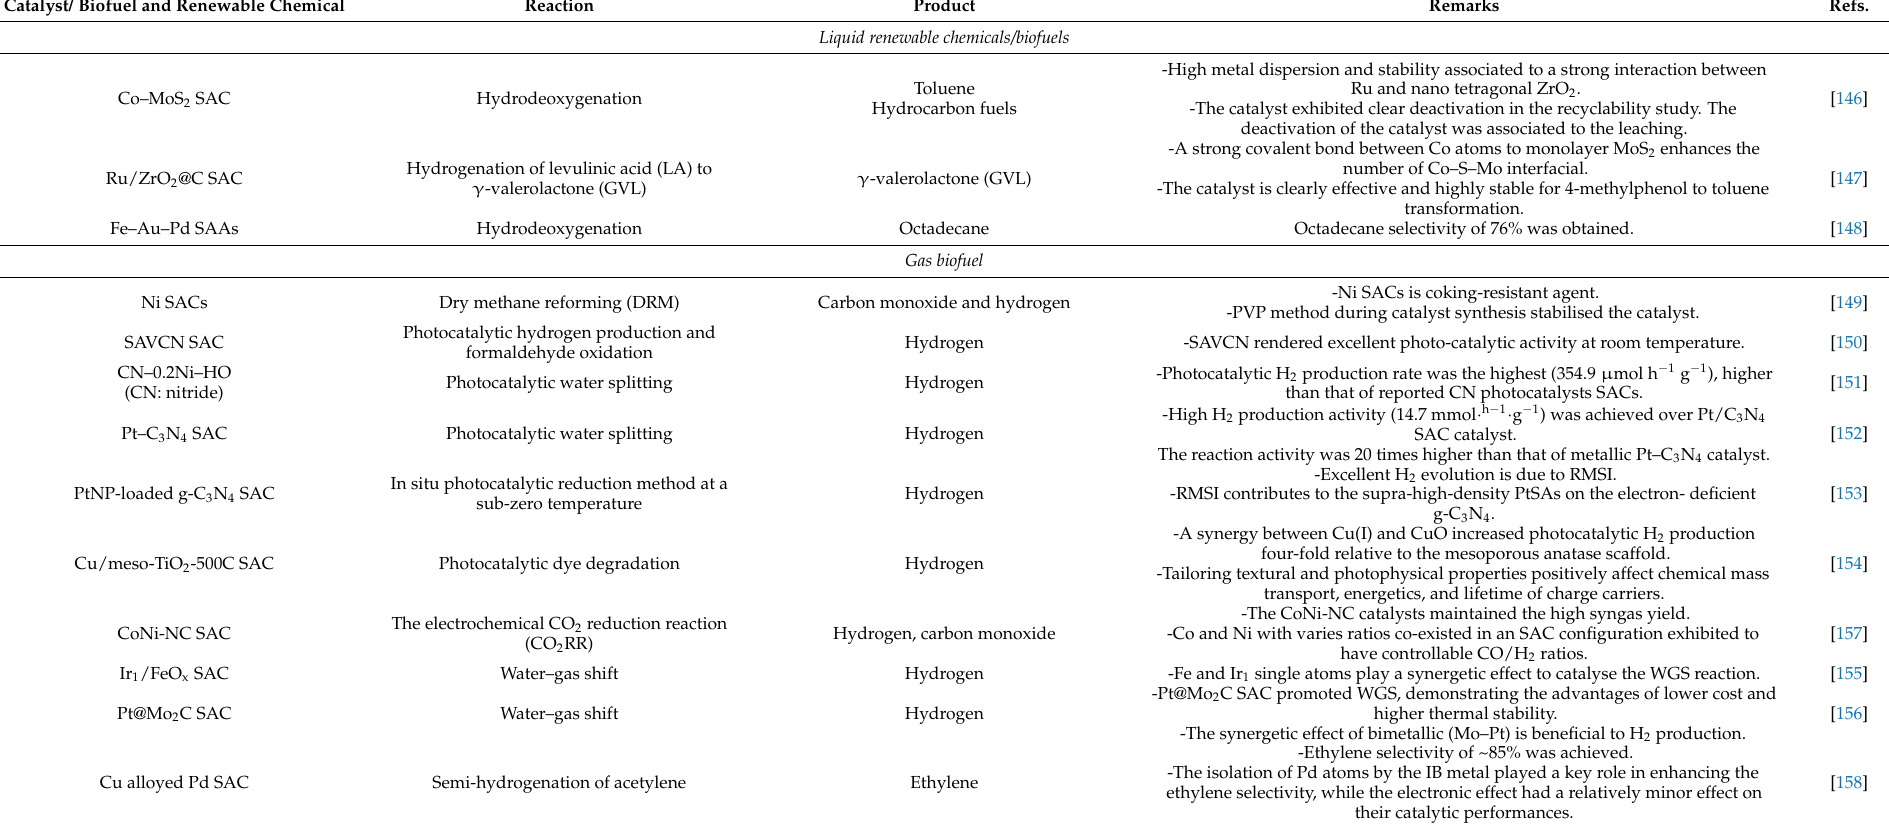
Table 3. Summarisation of SACs and SAAs in the production of biofuel and renewable